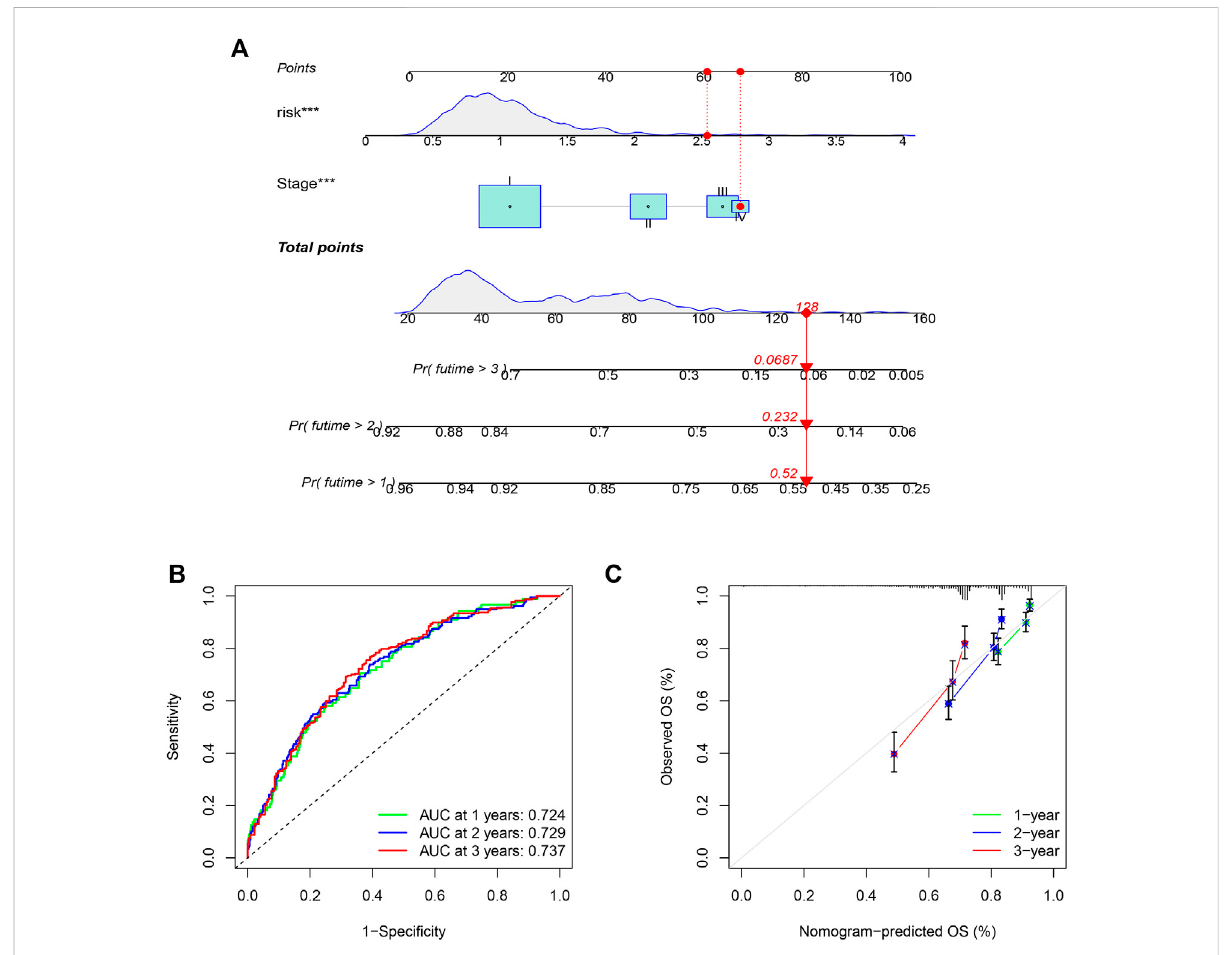
FIGURE 5 Nomogram was assembled by stage, and risk score for predicting the survival rate of LUAD patients (A) . ROC curves of the nomogram for predicting the 1/2/3-year survival (B) . 1/2/3-year nomogram calibration curves (C) . The results show that the nomogram model has very good predictive performance for prognosis (*** p <